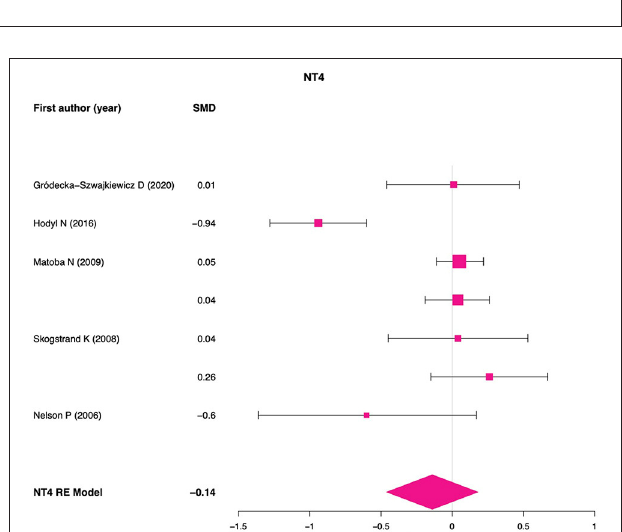
FIGURE 3 | NT-3 meta-analysis. RE, random effects model.